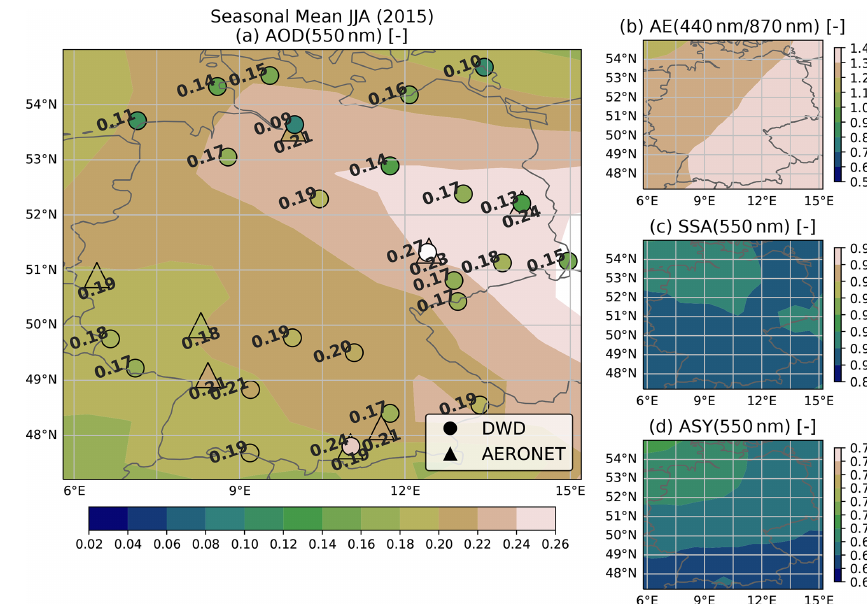
Figure D6. As Fig. 11 but showing the average over summer 2015.